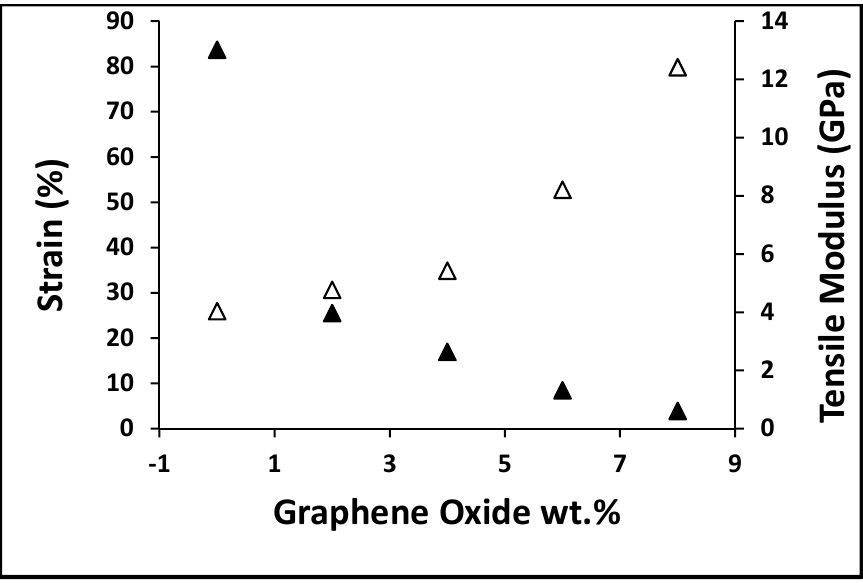
Figure 12. Tensile Modulus (GPa) ( ∆ ) and Strain variation ( ▲ ) in ArGrO composites with different Wt.% of GrO.